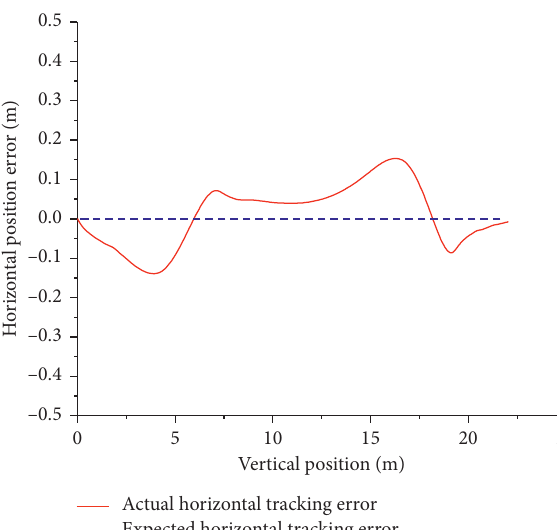
Figure 12: Simulation diagram of horizontal position tracking error.